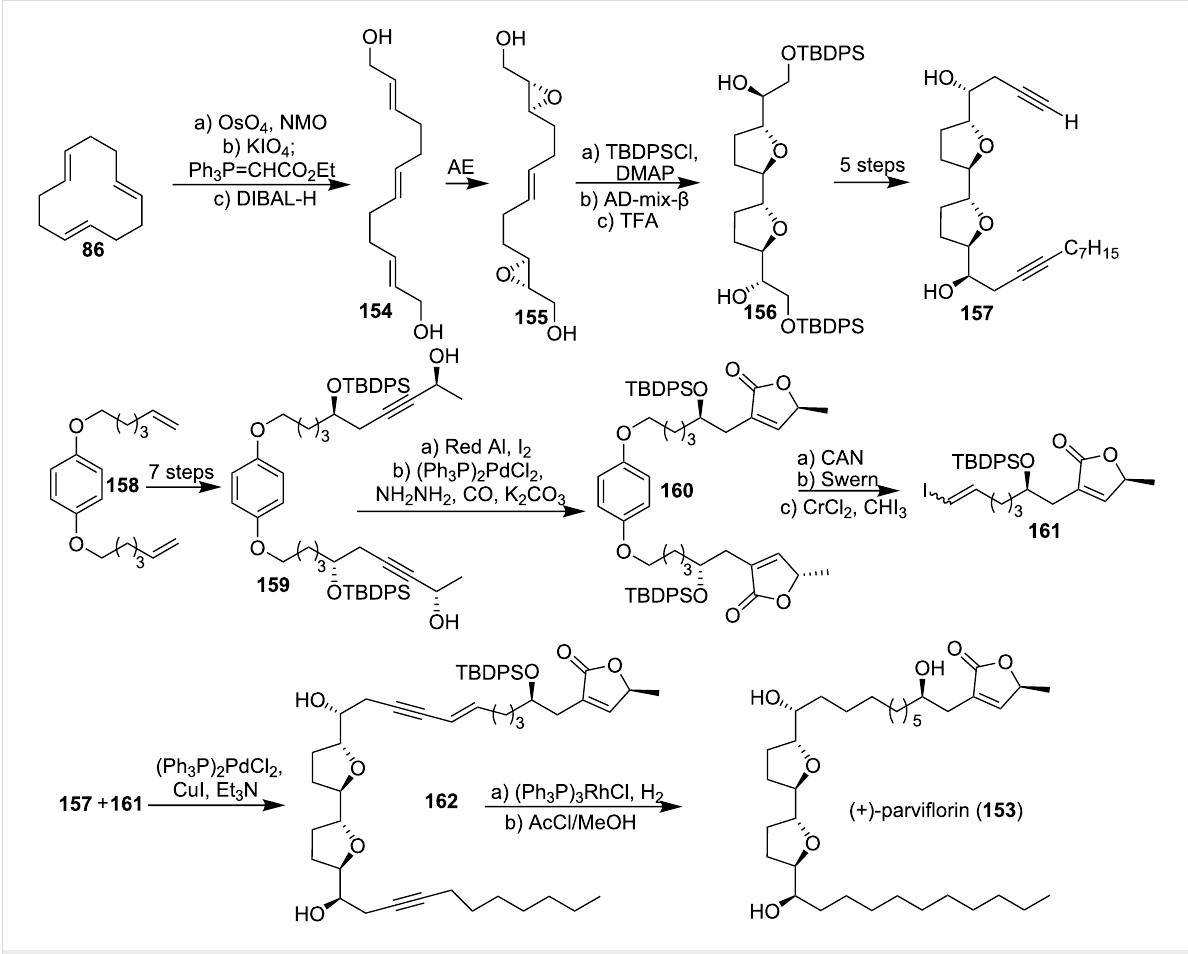
Scheme 22: Total synthesis of parviflorin by Hoye’s